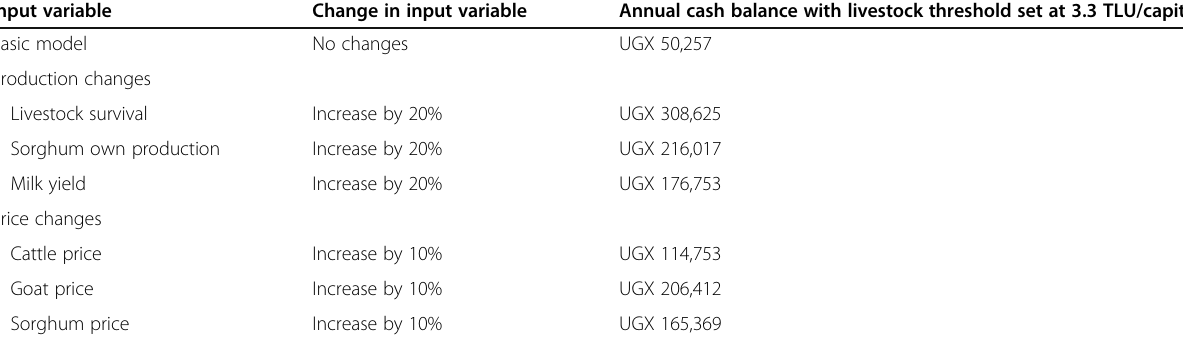
Table 4 Effect of changing livestock production and livestock and cereal prices on household cash balance